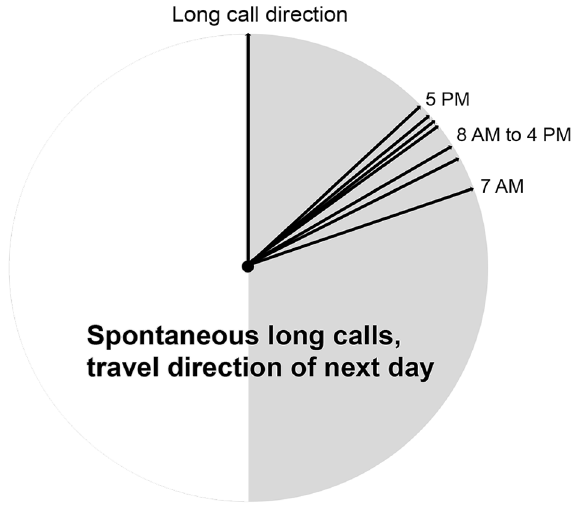
Figure 5. Deviation between evening long call direction and travel direction of the next day. The graph depicts the median of deviation angles between travel direction and the direction of the last spontaneous long call of the previous day, given shortly before nesting or from the nest. Time is clock time during the day following the long call. Statistics are given in Table